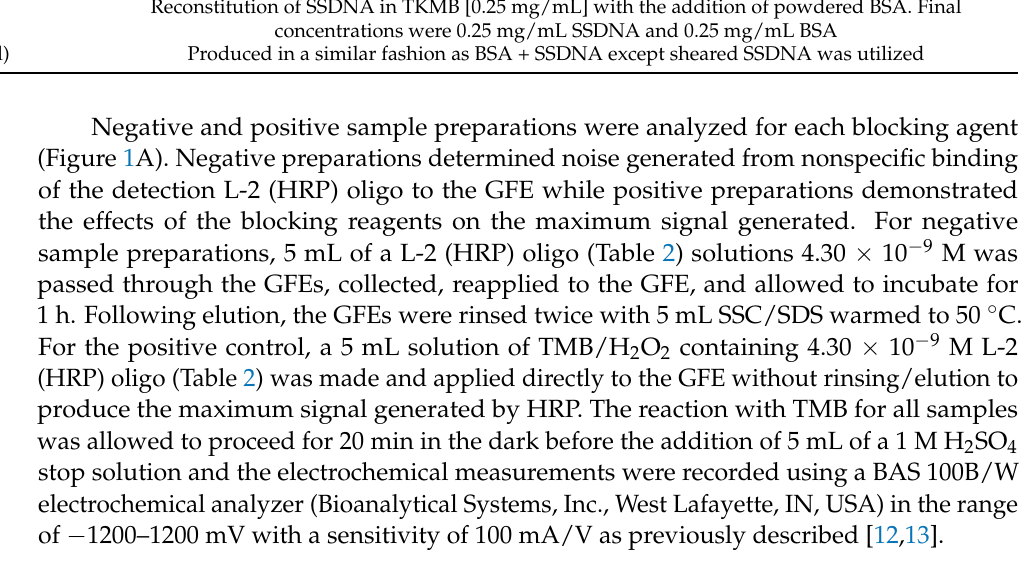
Table 1. Blocking solutions used during the development of the enzyme-amplified electrochemical biosensor.